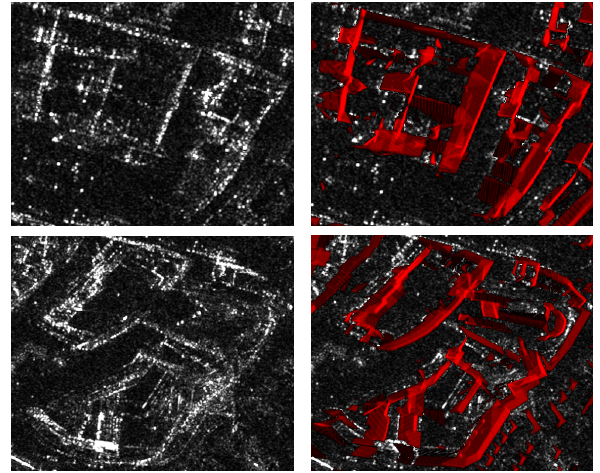
Figure 9. Close-up view on building blocks. HH dominates VV in intensity (mean, median) but also tends to show stronger intensity variation (standard deviation). In con- trast, no tendency with respect to the proportion between HH and VV is observed on the number of prominent point